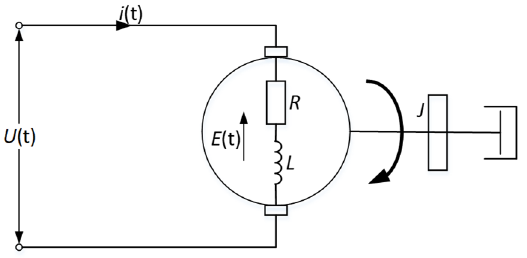
Figure 2. Model diagram of the flywheel motor.